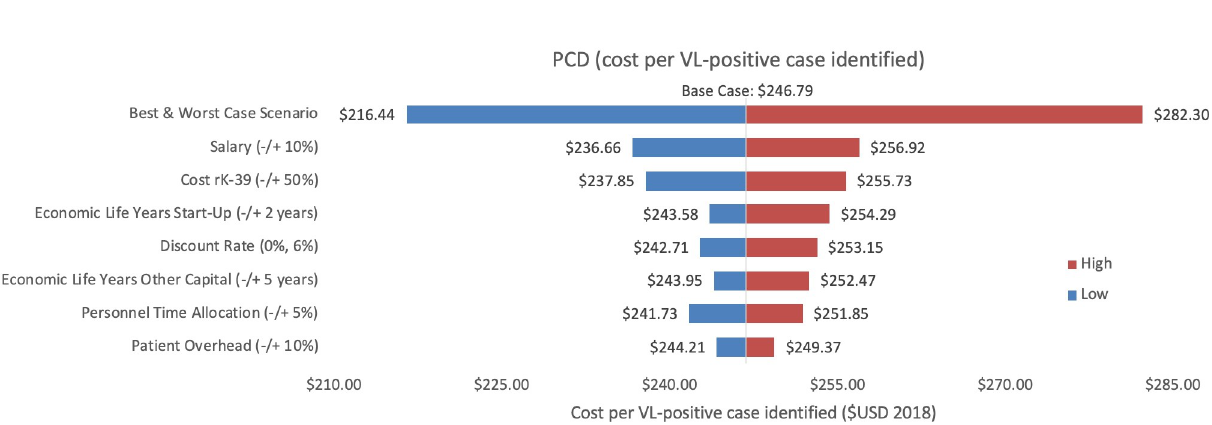
Fig 5. Sensitivity analysis of PCD costs per VL-positive case identified. Variations in PCD cost per VL-positive case identified in Bihar during 2018.